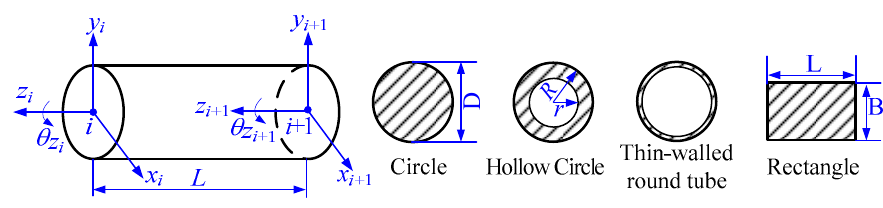
Figure 5. Timoshenko beam.